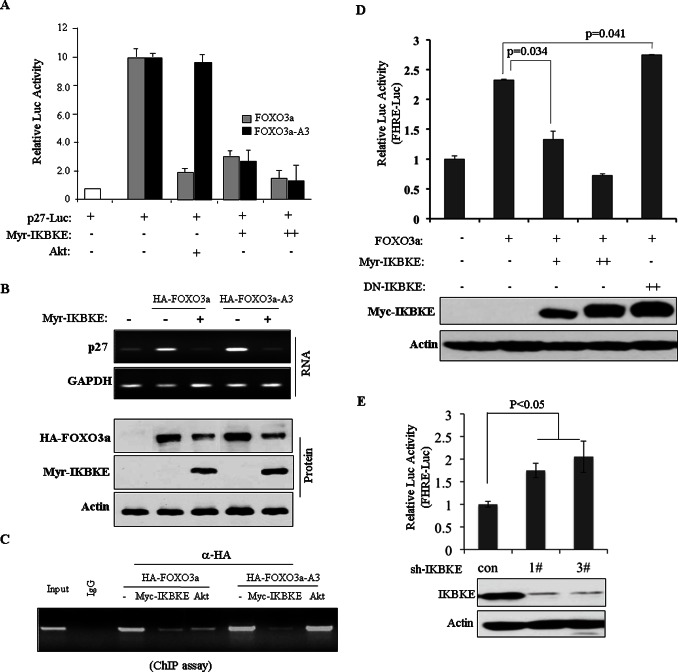
IKBKE represses FOXO3a and Akt-nonphosphorylatable FOXO3a-A3.(A) Luciferase assay. H1299 cells were transfected with pGL3-p27-Luc together with indicated plasmids. Following incubation for 48 h, luciferase activity was measured and normalized to β-galactosidase. Results are the mean ± S.E. of three independent experiments performed in triplicate. The left open bar is relative basal p27-promoter activity (1.0). (B) FOXO3a- and FOXO3a-A3-induced p27 transcription was reduced by IKBKE. H1299 cells were transfected with indicated plasmids. The p27 mRNA levels were determined by semi-quantitative RT-PCR (upper panels). GAPDH was used as control. Western blot shows the expression of transfected plasmids (panels 3 and 4). Bottom panel is a loading control. (C) IKBKE inhibits FOXO3a and FOXO3a-A3 DNA-binding activity. H1299 cells were transfected with indicated plasmids. ChIP assay was performed as described in “Experimental Procedures”. Anti-HA antibody was used for chromatin IP. IgG was served as negative control. The DNA prior to the IP was used as positive controls (input). (D) IKBKE inhibition of FOXO3a depends on its kinase activity. MCF7 cells were transfected with pGL3-FHRE-Luc (e.g., 3 repeats of FOXO binding motif) and IKBKE or DN-IKBKE. Luciferase activity was determined after 48 h of the transfection. Western blot shows expression of transfected plasmids (bottom). (E) Knockdown of IKBKE increases FOXO3a transcription activity. H292 cells were transfected with 2 shRNA of IKBKE and pGL3-FHRE-Luc. After 48 h of incubation, cells were subjected to luciferase assay (upper panel) and Western blot (bottom panel).